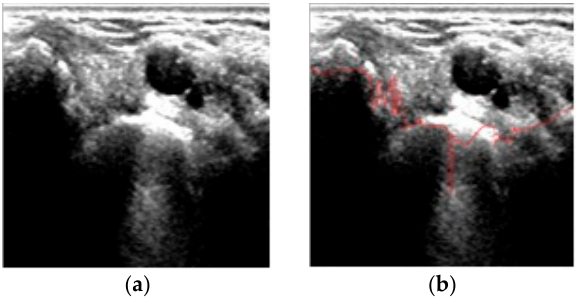
Figure 5. Effect of cubic spline interpolation. ( a ) After stretching, ( b ) after cubic spline.